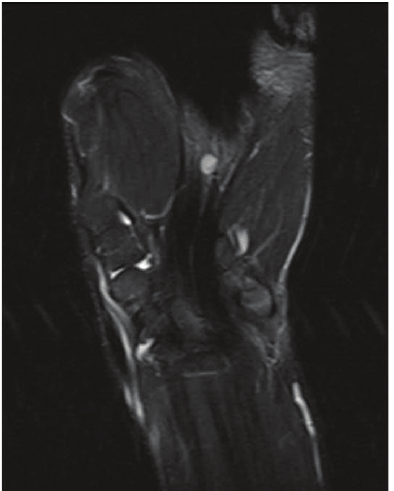
Figure 2: 6mm diameter mass in the palm which has intermediate signal on T1-weighted images and hyperintense signal on T2-fat weighted images was detected.